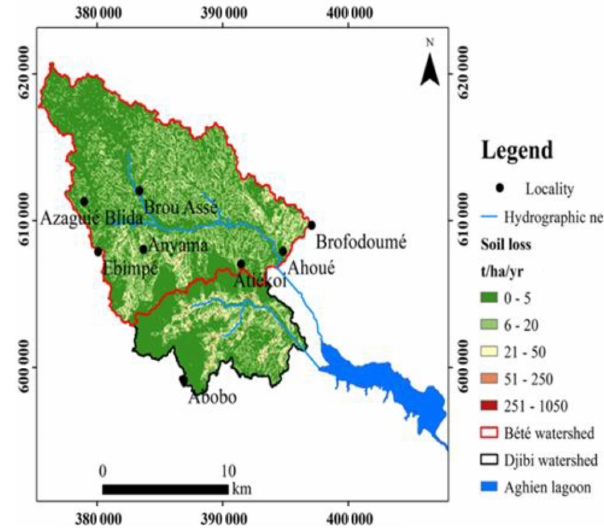
Figure 5. Soil loss in Aghien lagoon tributaries watershed (2016).